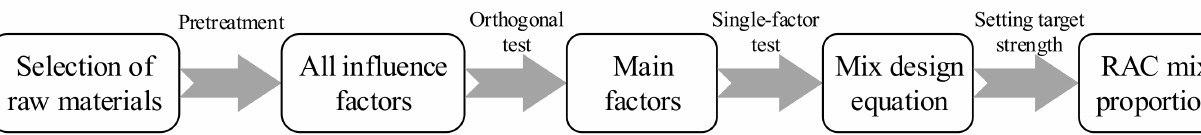
Figure 5. Process of simple mix design method of RAC.